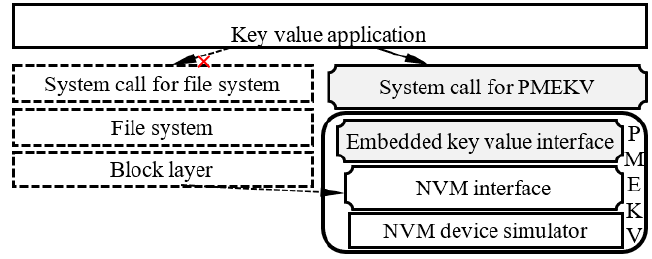
Figure 4. The interface of PMEKV.